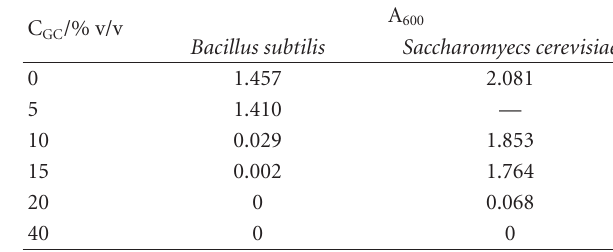
Table 1: E ff ect of GC concentration on growth of microbes.